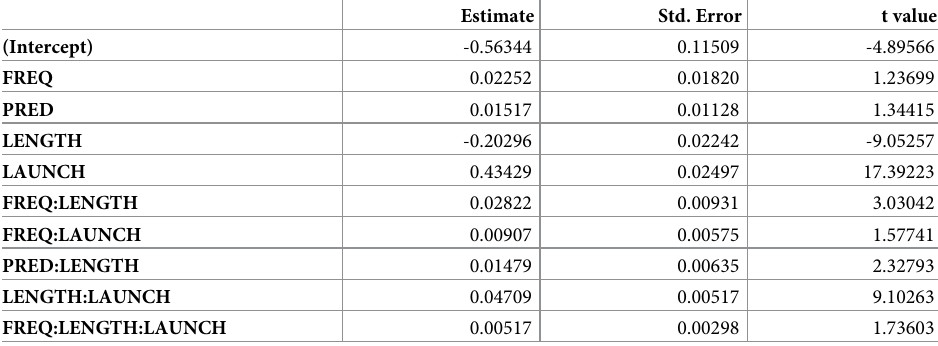
Table 6. Fixed effects of optimal LMM for initial landing positions in the test words.